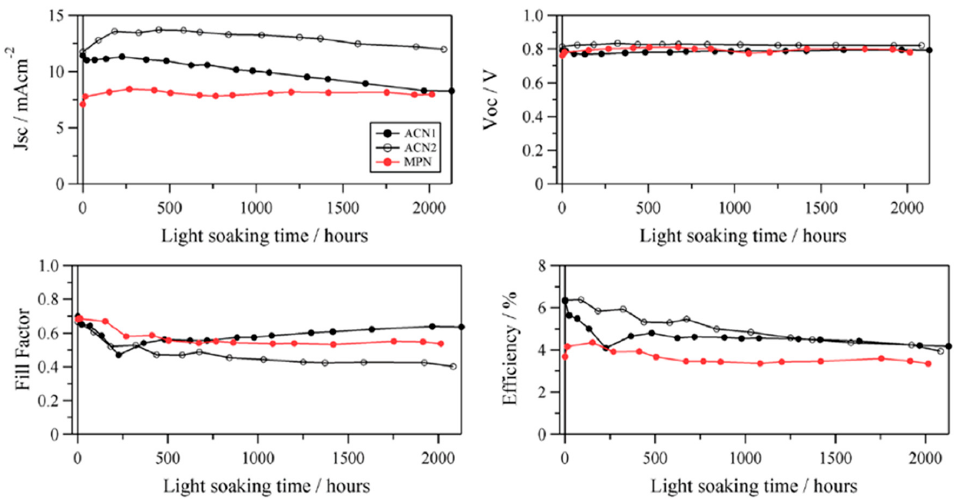
Figure 3. Performance parameters of cells subjected to 2000 h of continuous light soaking at one sun equivalent (LED illumination) and 20 °C. Adapted and reprinted with permission from [53].